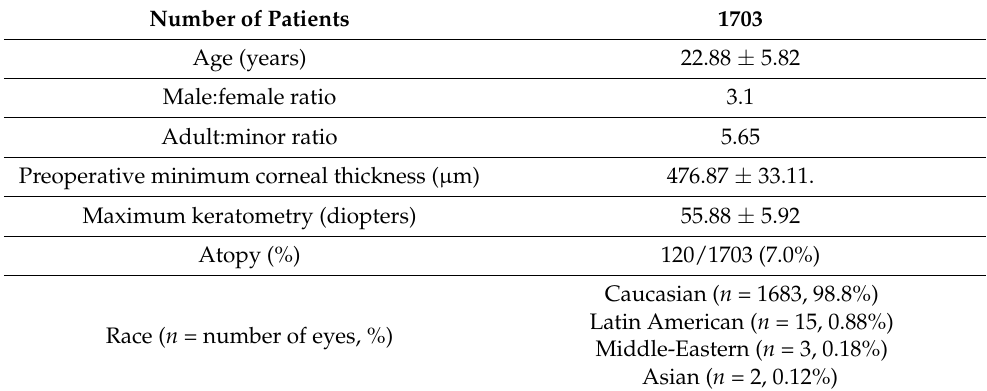
Table 1. Demographic and clinical characteristics of patients undergoing collagen cross-linking.